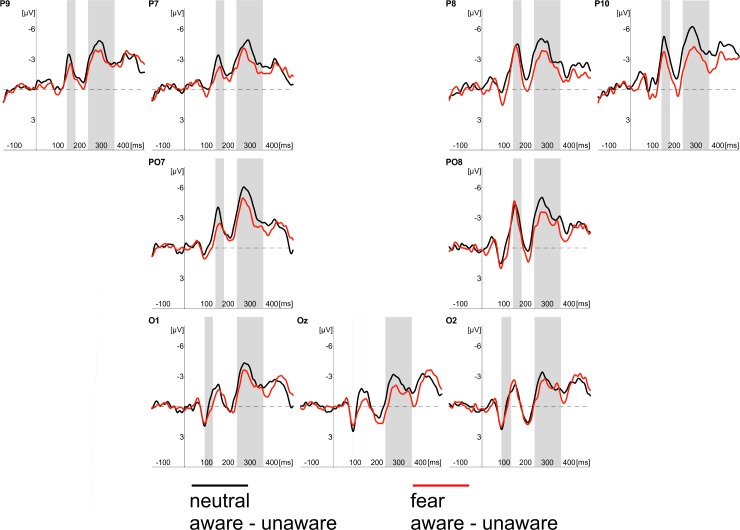
Difference waves computed as differences between aware and unaware conditions recorded in the CR task at occipital (O1, Oz, O2) and occipito-temporal (P7, PO7, P9, P8, PO8, P10) electrodes in response to neutral (black lines) and fearful faces (red lines).Time windows for the region of interest (P1 component; 90-115ms post-stimulus; N170 component; 145-180ms post-stimulus; EPN component 240–340 ms post-stimulus) are highlighted at corresponding electrodes; time 0 indicates stimulus onset.